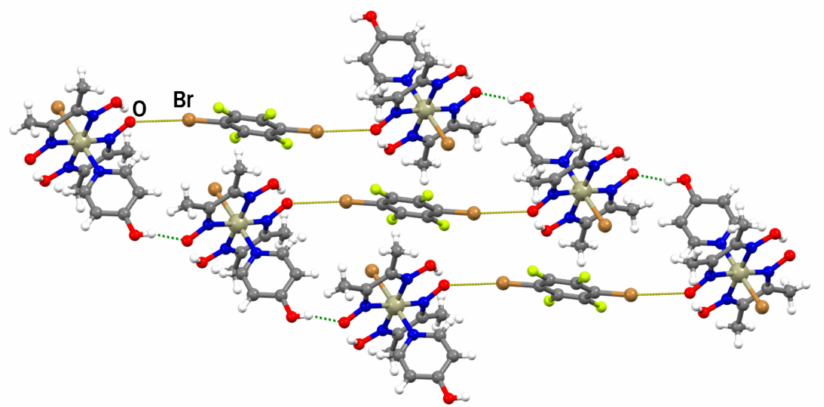
Figure 6. Halogen-bonded units of ( III ) 2 ( 14tfbb ) connected by O–H ··· O hydrogen-bonds into a